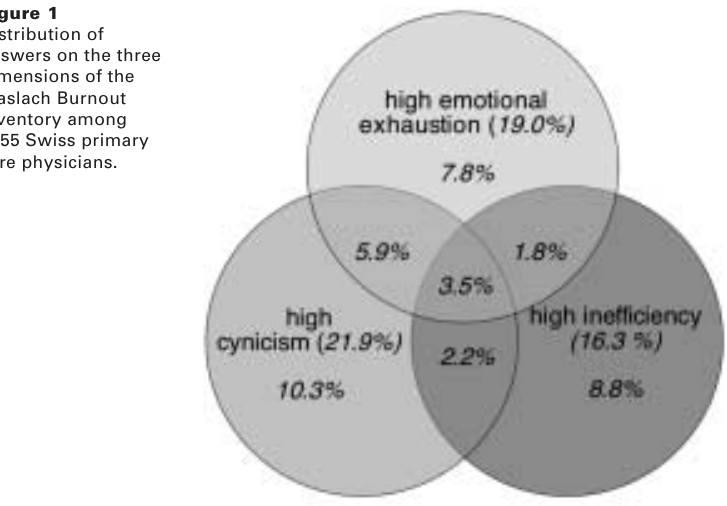
Figure 1 Distribution of answers on the three dimensions of the Maslach Burnout Inventory among 1755 Swiss primary care physicians.